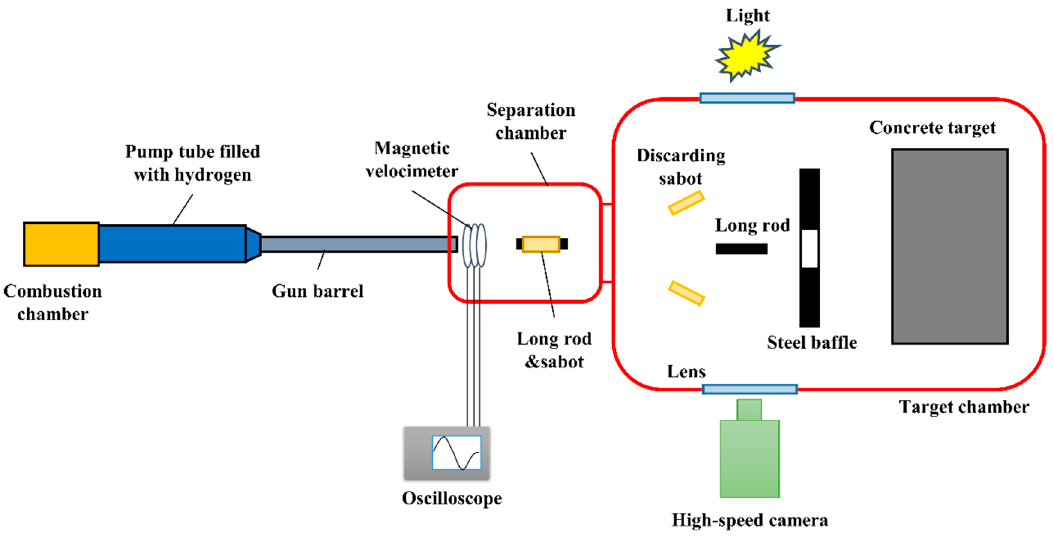
Figure 2. Schematic diagram of the testing system.